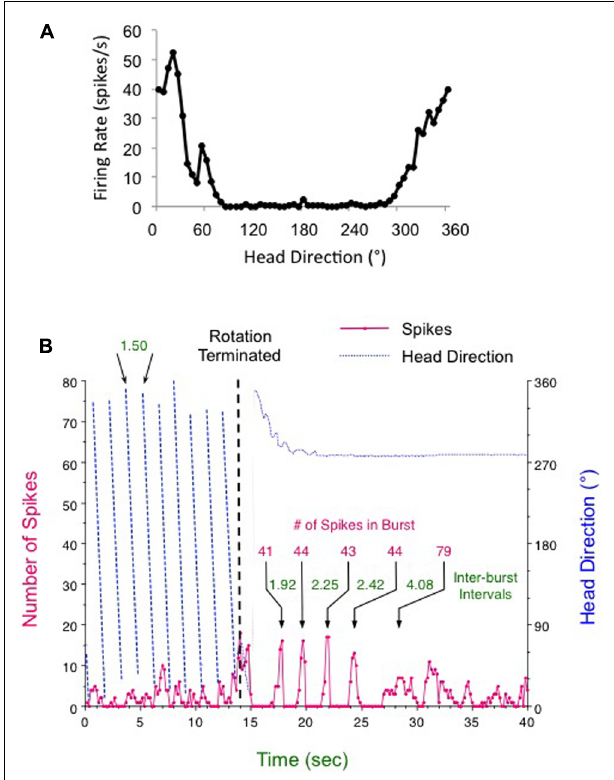
FIGURE 2 | Head direction cell responses following (A) an active foraging session in the cylinder and (B) continuous clockwise rotation for 1 min (only the final 14 s are shown) followed by abrupt braking (vertical dashed line). After termination of rotation the HD cell fired in five periodic bursts over about 10 s. For this post-rotation period the amount of time in between each burst increased over each interval (times denoted in green for each inter-burst interval), although the number of spikes composing each burst (denoted in red) was about the same – particularly for the first four bursts. See text for further